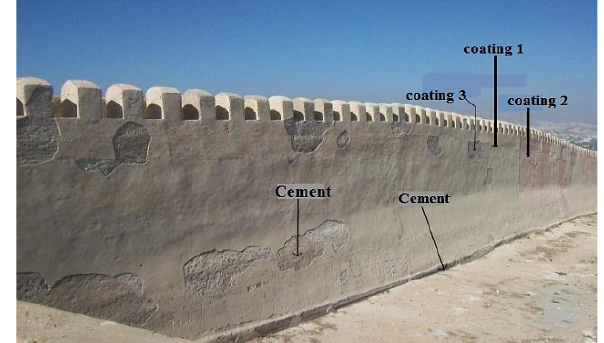
Figure 3. Degradation of the architectural elements of the kasbah due to the mismatch between building materials.